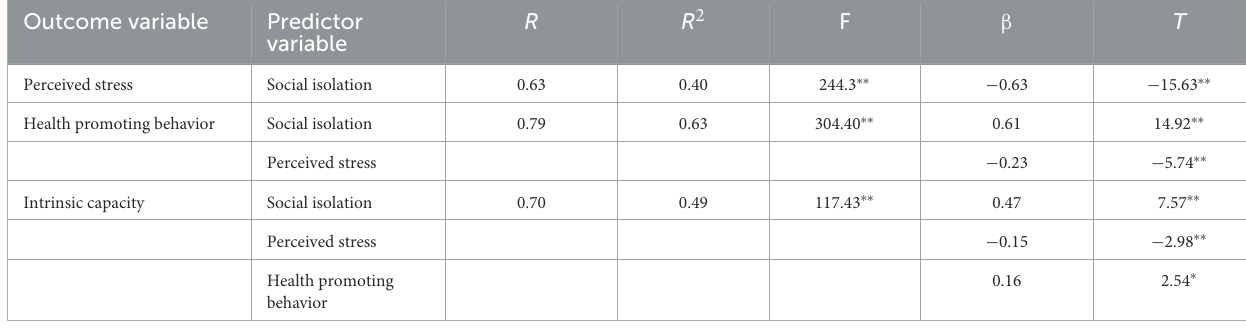
TABLE 3 Regression analysis among variables in the chain intermediary model.